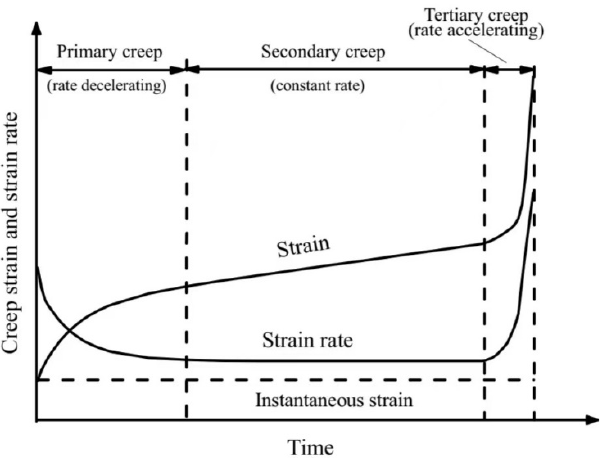
Figure 1. Sketch showing the creep behavior of rocks (Reprinted from Qian et al. [25], Copy- right©2022, with permission from the publisher, License No. 5352440395617).